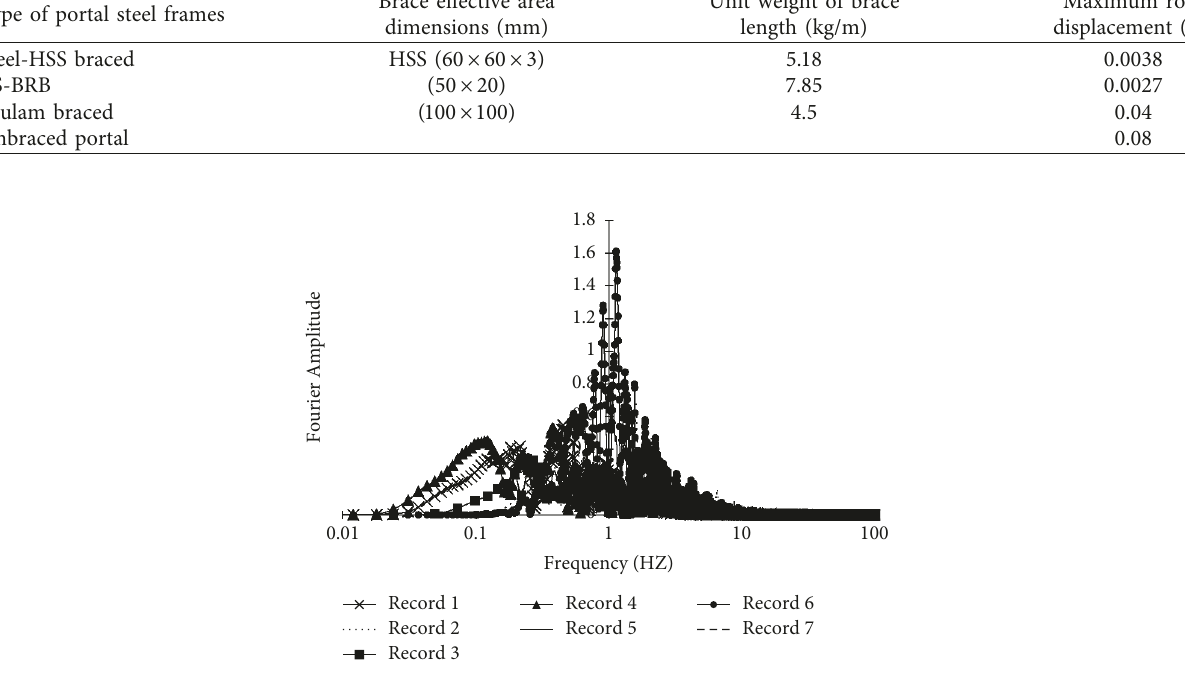
Figure 32: Fourier spectra of the seven studied earthquakes. Table 14: Summary of decrease values in maximum roof displacement under selected record of different